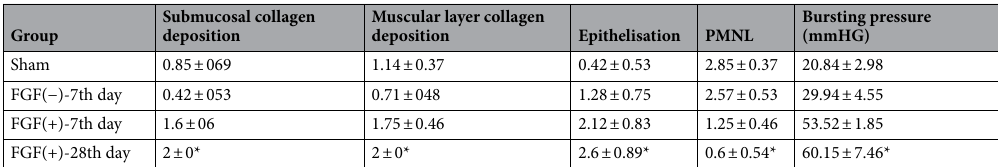
Table 3. Results of the semi-quantitative histopathological evaluation and bursting pressure, presented by its mean and standard deviation (mean ± sd). M, mean, SD, standard-deviation. *Chi-square test, significant at 0.05 level, (p <